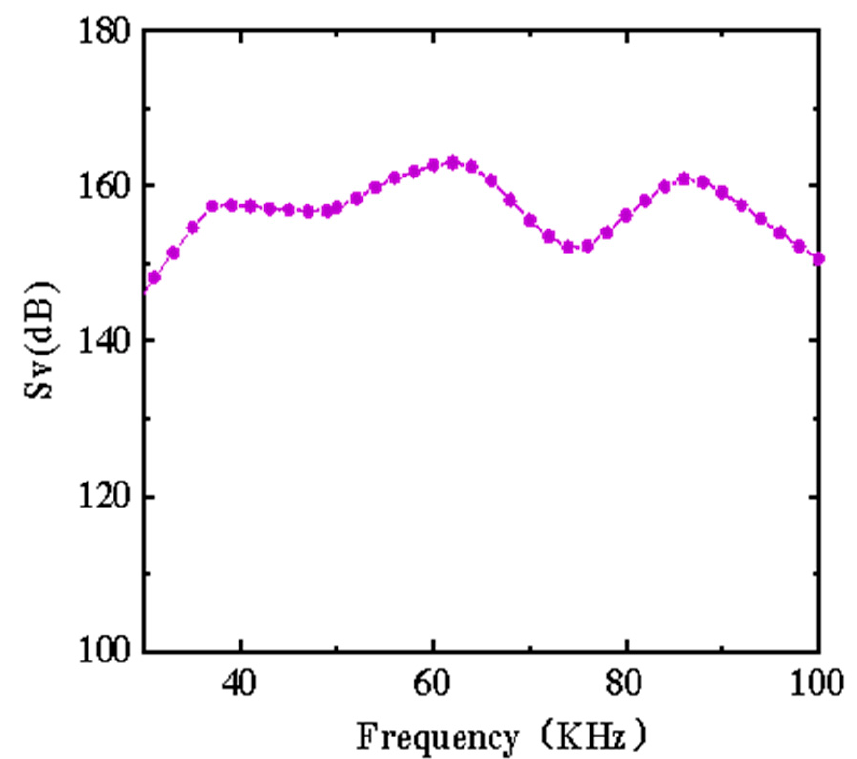
Figure 13. Transmitting voltage response of transducer array.